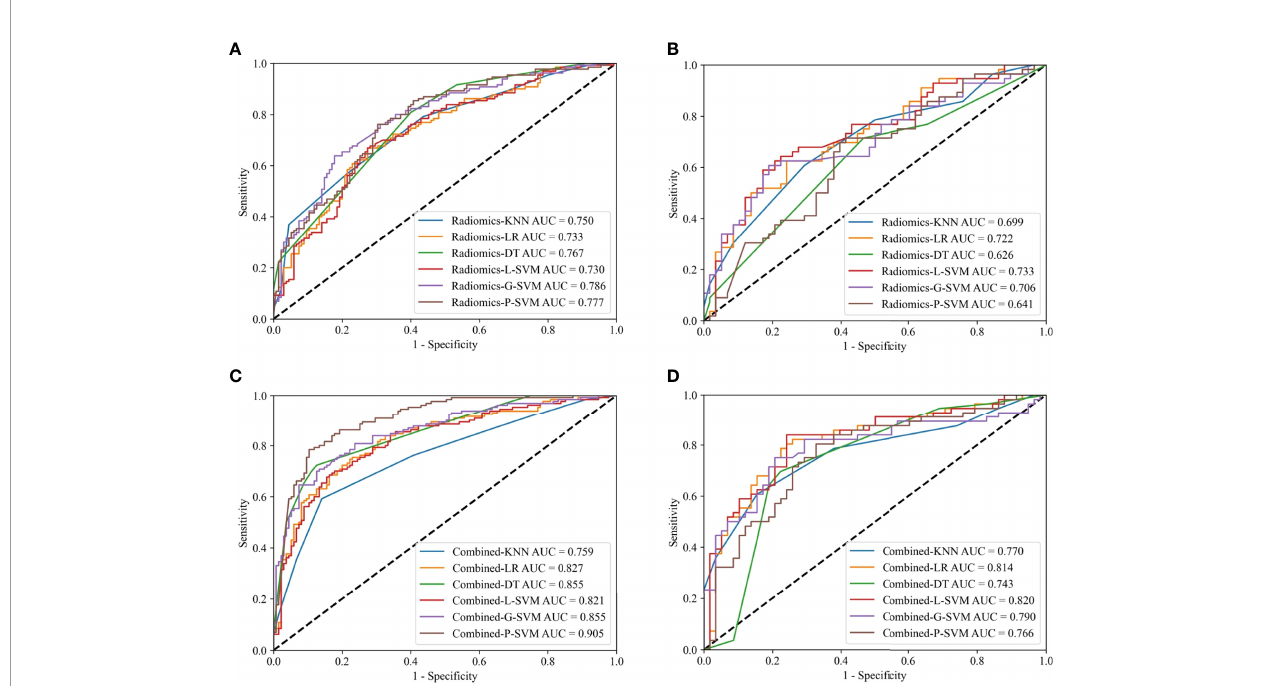
FIGURE 4 | ROC curves for the radiomics models in the training (A) and internal test (B) cohorts; ROC curves for the combined models in the training (C) and internal test (D) cohorts.